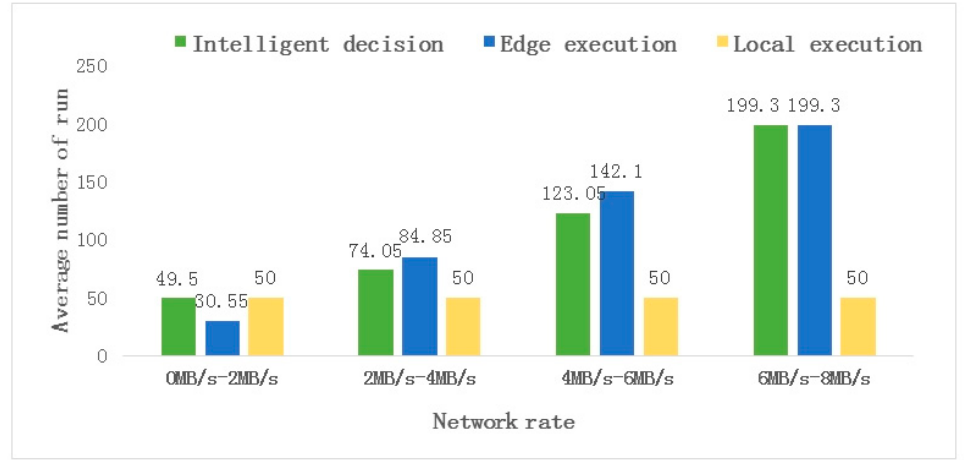
Figure 8. Average running times.